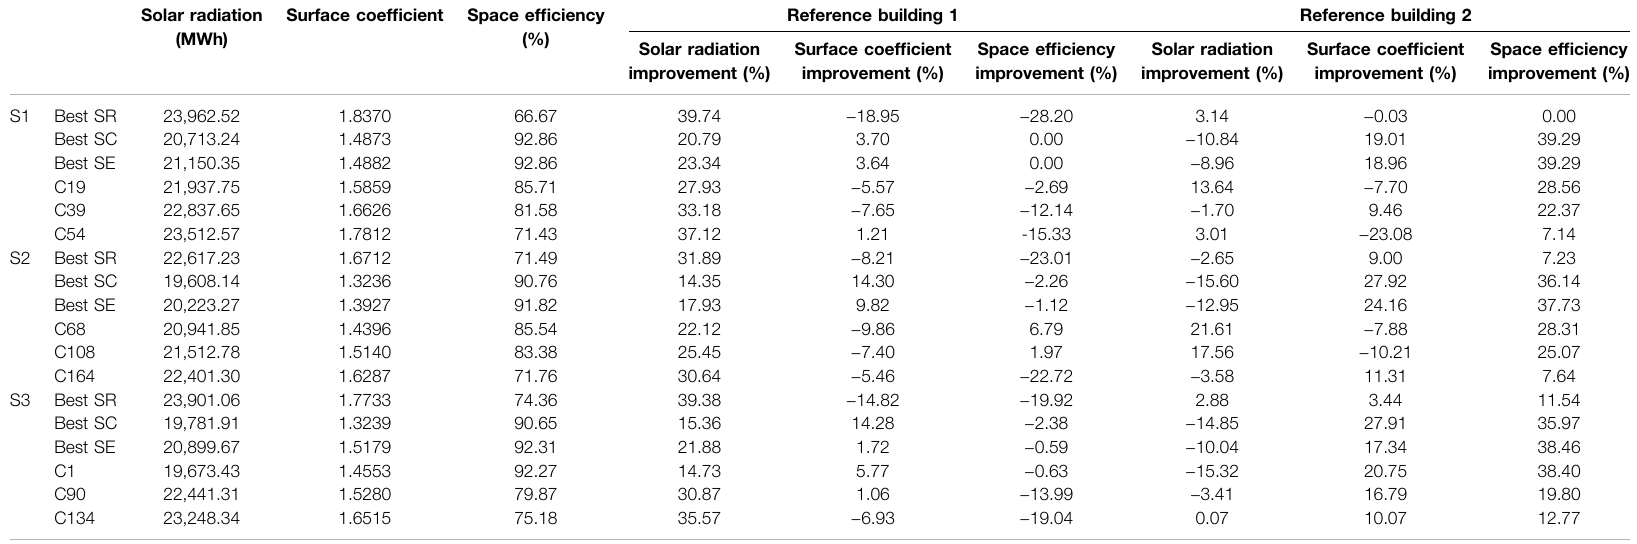
TABLE 4 | Performance of S1-S3 characteristic solutions and comparison with reference buildings 1 and 2. Solar radiation